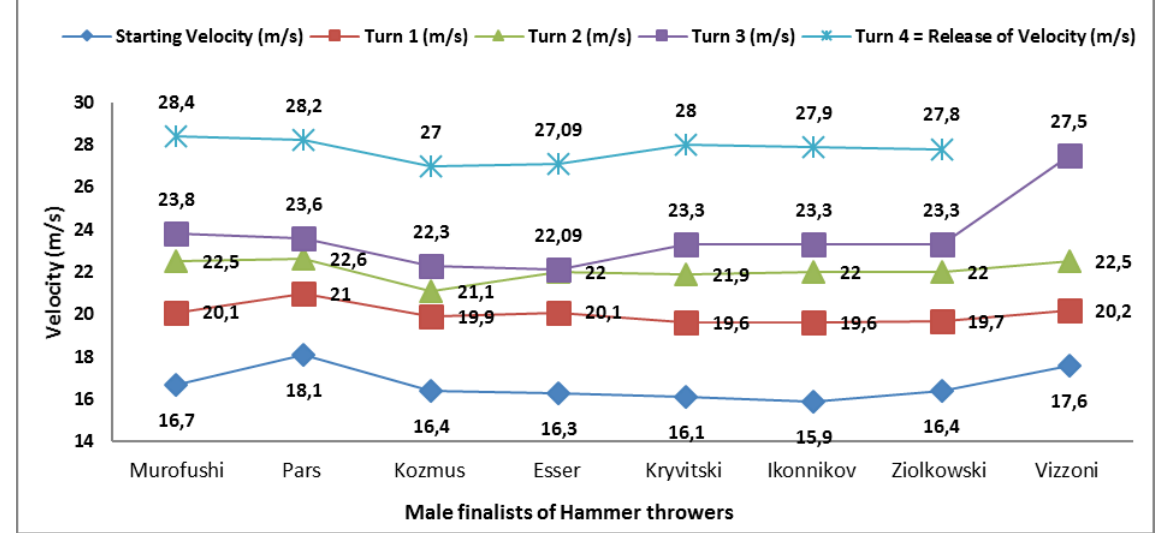
Figure 1. Distribution of male results in kinematics